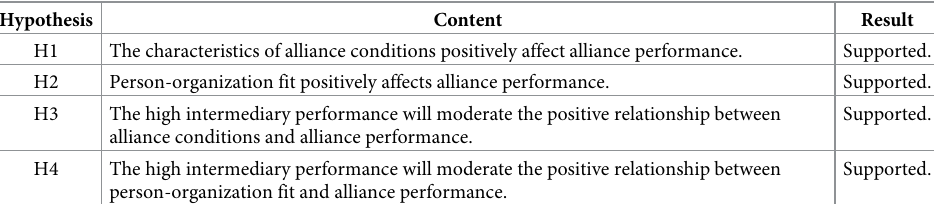
Table 5. Summary of the hypotheses